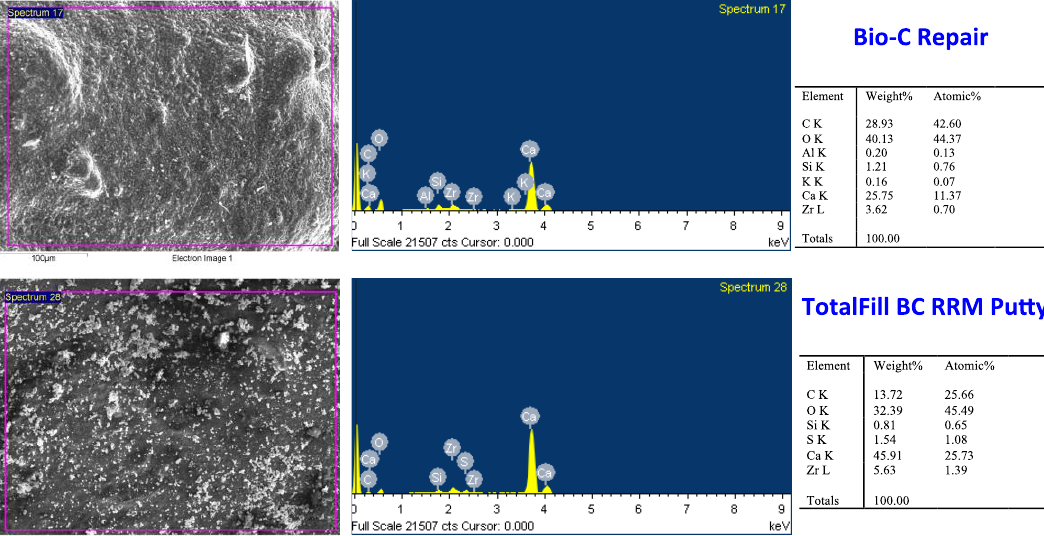
Figure 5. Scanning electron microscopy with energy-dispersive X-ray analysis (SEM-EDX) evaluation. Surface properties and composition of BCR and TFB. SEM image ( left column ), EDX spectra ( middle column ), and table of elements ( right column ). Scale bar represents 100 μm for all images.